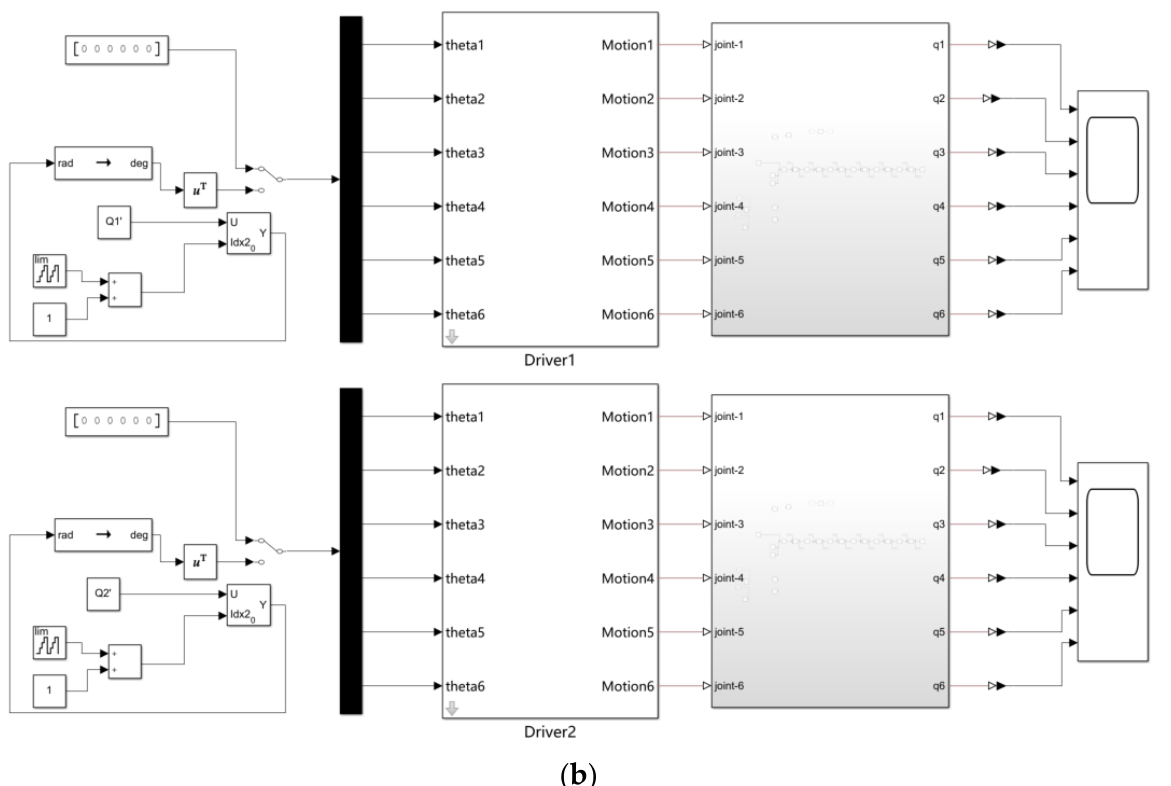
( b ) Figure 14. Double-arm simulation model. ( a ) Simscape model. ( b ) Simulink model.